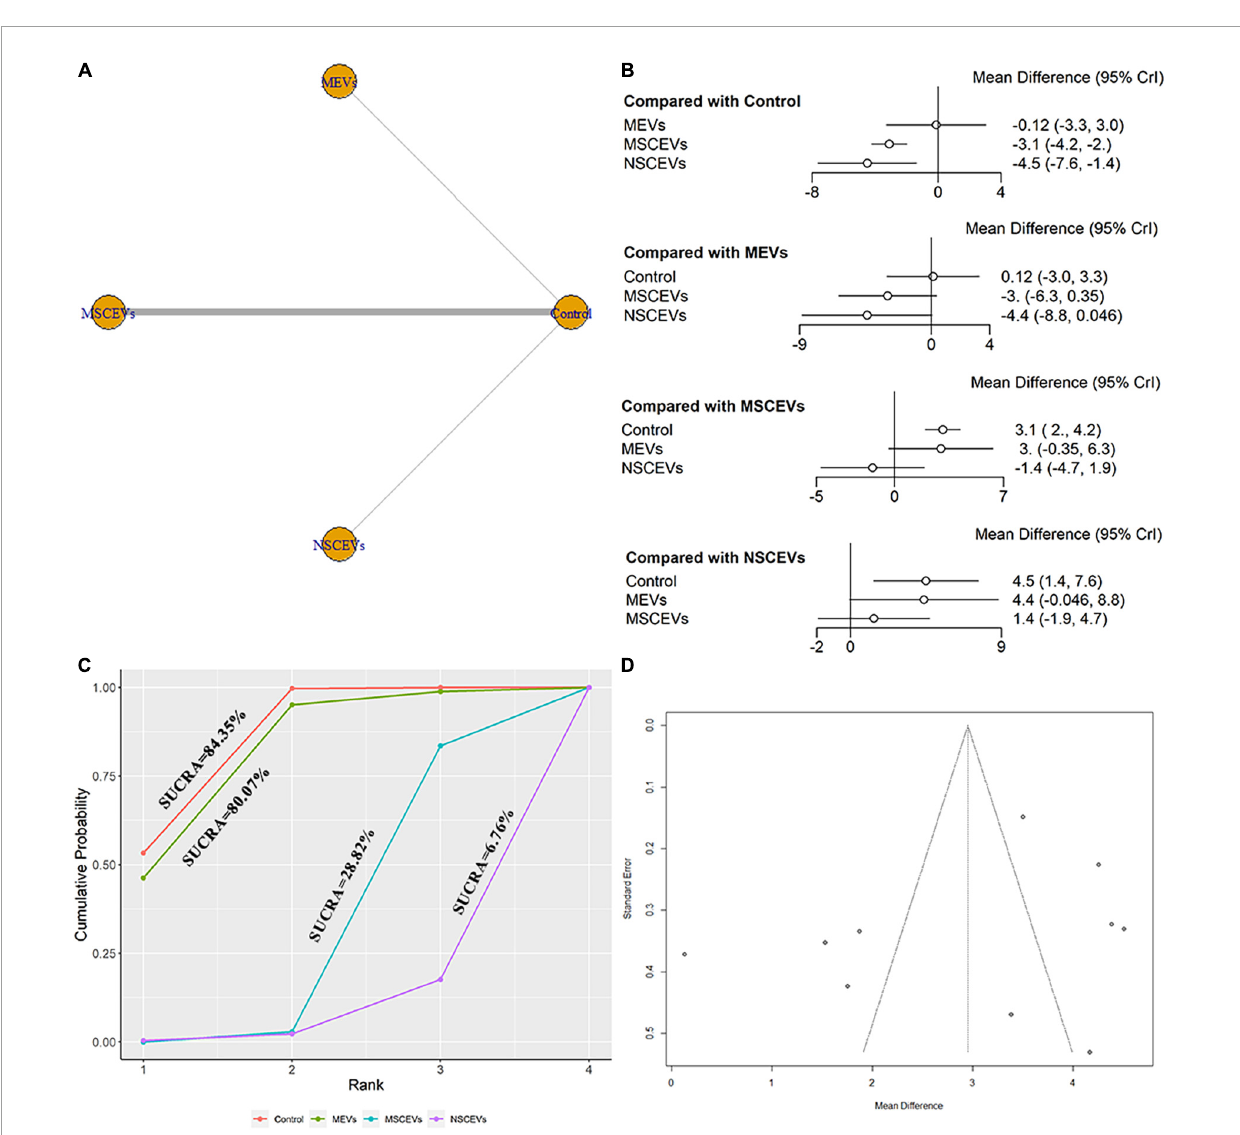
FIGURE6 Comparison of the efficacy of extracellular vesicles (EVs) from different cell sources in modified Neurological Severity Score (mNSS) at day 21 post-traumatic brain injury (TBI). (A) Network plot; (B) Forest plot; (C) Surface under the cumulative ranking curves (SUCRA); (D) Funnel plot. The dotted lines represent 95% confidence interval (95% CI). AEVs, astrocyte-derived extracellular vesicles; MEVs, microglia-derived extracellular vesicles; MSCEVs, mesenchymal stem cell-derived extracellular vesicles; NSCEVs, neural stem cell-derived extracellular vesicles.